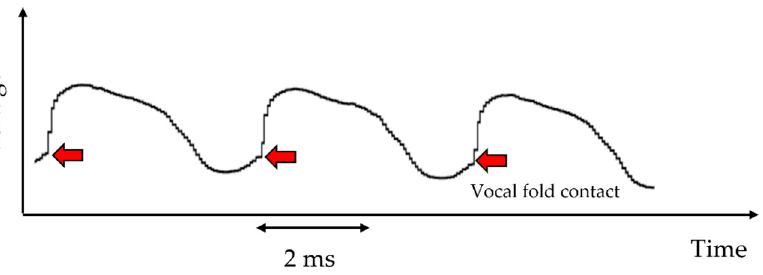
Figure 6. Electroglottograph signal for three vocal fold vibratory cycles recorded by an electrolaryn- gograph, here displayed by the software Sopran. The sudden voltage changes (red arrows) represent an initiation of vocal fold